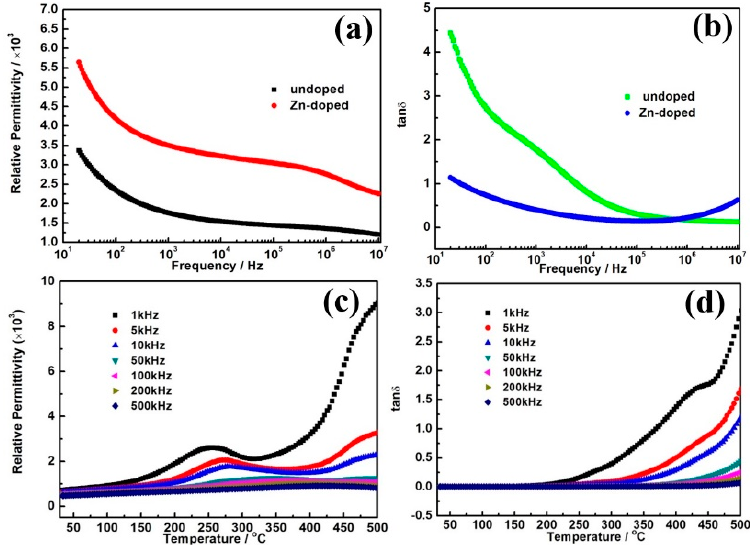
Figure 4. The relationships of frequency and permittivity, loss for undoped ( a ) and Zn-doped CCTO ( b ). Permittivity and loss for Zn-doped CCTO measured from 30 to 500 °C ( c , d ).